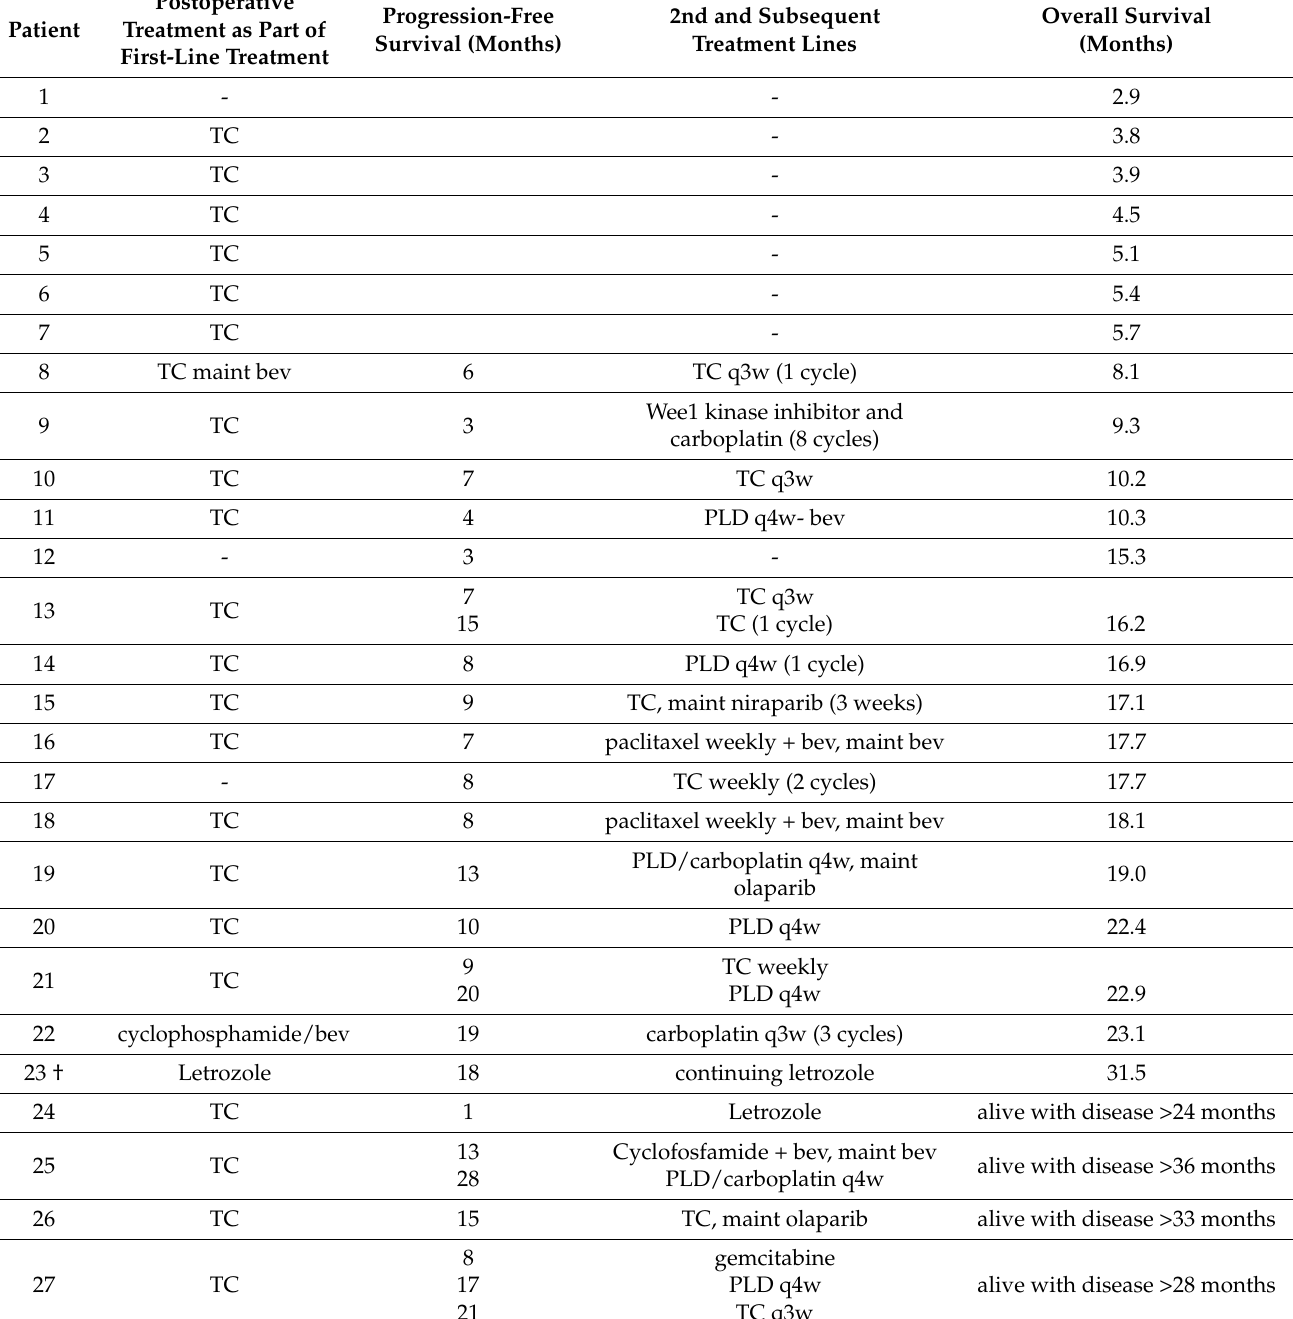
Table 3. Postoperative treatment and overall